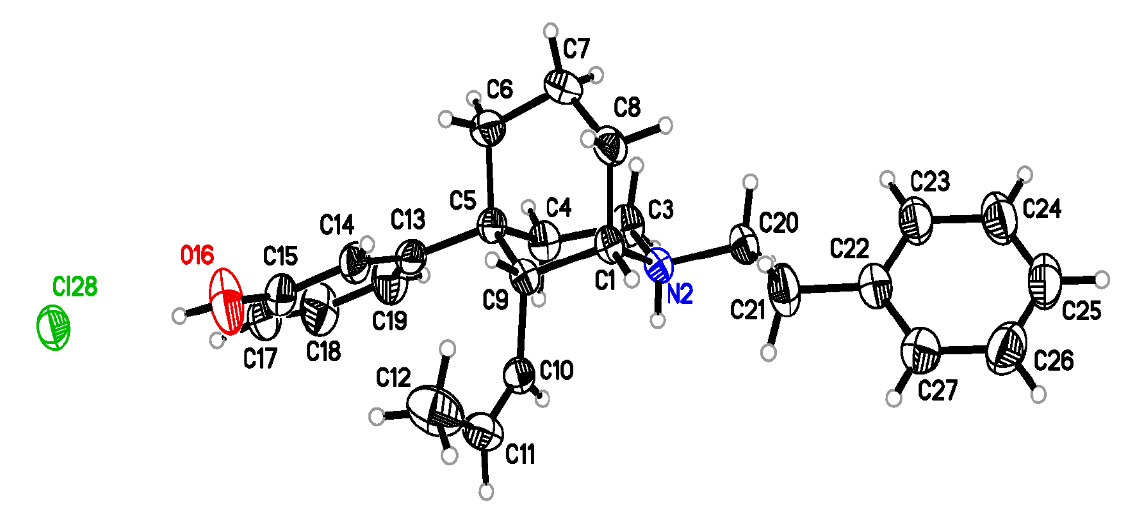
Figure 2. X-ray crystal structure of 20 (3-((1 S ,5 R ,9 R )-2-phenethyl-9-(( Z )-prop-1-en-1-yl)-2-azabicyclo [3.3.1] nonan-5-yl) phenol). The ellipsoids are shown at the 50% probability level. Crystal data and atomic coordinates can be found in the Supplementary Materials.